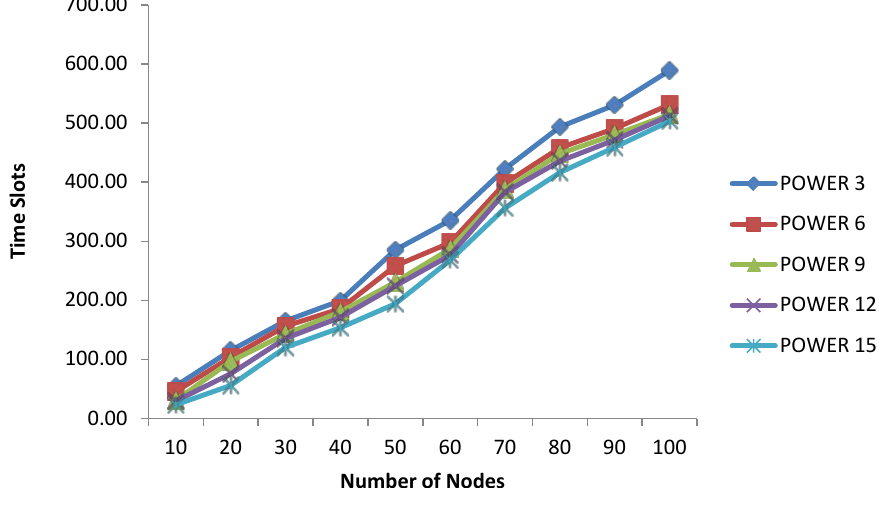
Figure 7. Scheduling time for convergecast in the general